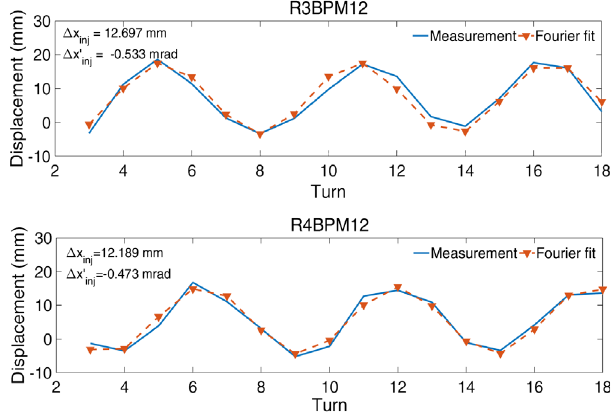
FIG. 7. The measurement results of betatron oscillation at two different BPMs (blue solid lines) and their Fourier fit (red dashed lines with